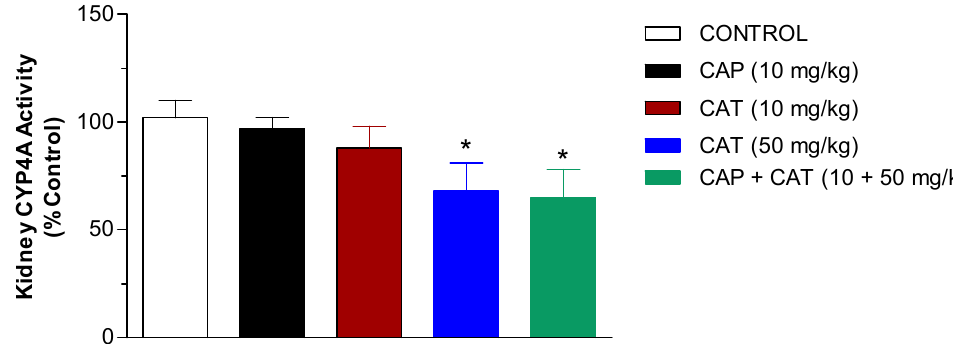
Figure 4. Effect of five week-daily oral treatment of SHR with catechin (CAT) and captopril (CAP) on CYP4A activity measured as 20-HETE formation rate. Data are presented as the mean ± SEM ( n = 6–9). * Significant difference from control group at 5 weeks, p < 0.05.